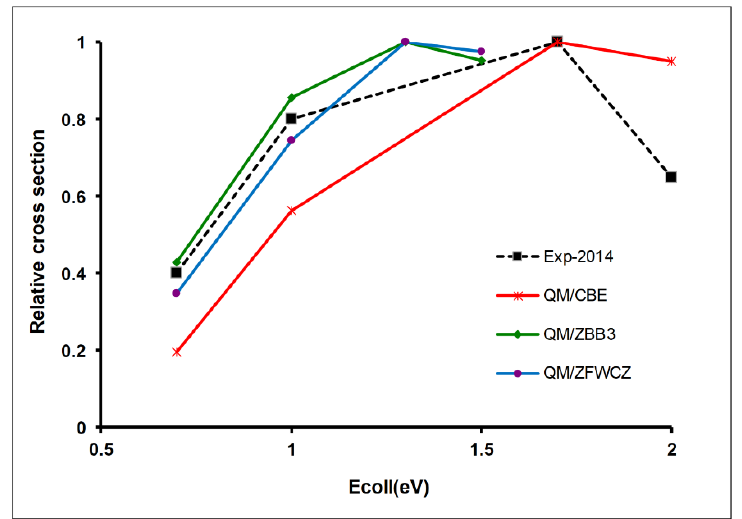
Figure 3. Relative integral cross-section versus collision energy (eV) for the H + CH 4 → H 2 + CH 3 reaction on the ZBB3–2006 [29], CBE-2009 [30] and ZFWCZ-2011 [31] surfaces using QM methods [37]. Experimental values from Ref. [36]. For a direct comparison, each series has been scaled to its maximum value because experimental measures represent relative values.